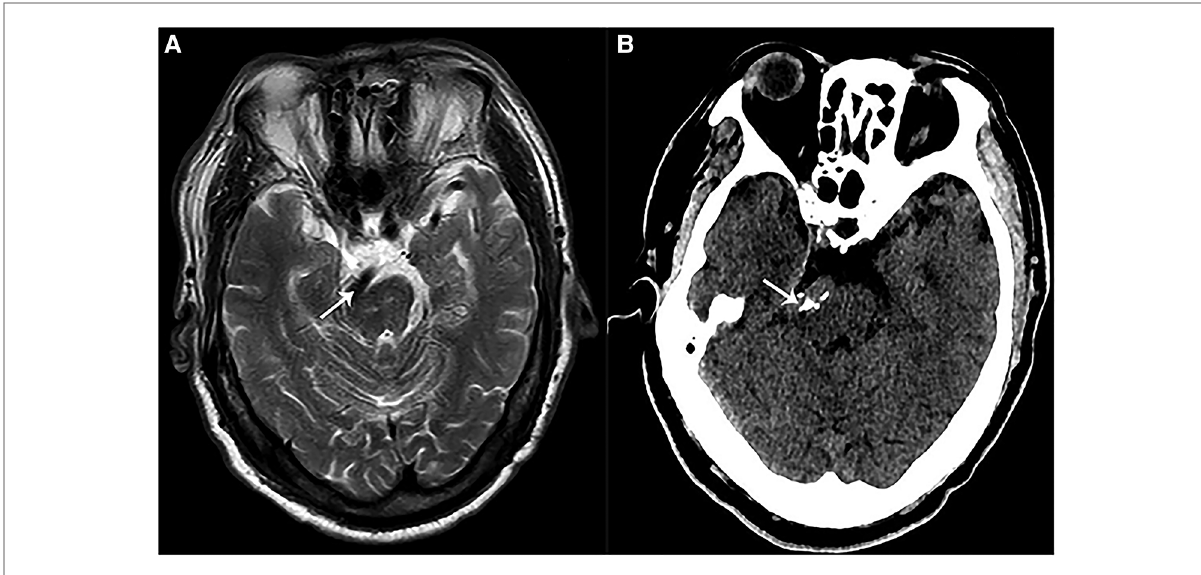
FIGURE 1 Preoperative imaging of a patient with VBA-associated HFS. ( A ) A preoperative magnetic resonance imaging (MRI) showed that VBA (white arrow) deformed and compressed the brainstem at pons. ( B ) A preoperative CT showed calci fi ed VBA (white arrow) which compressed the brainstem at